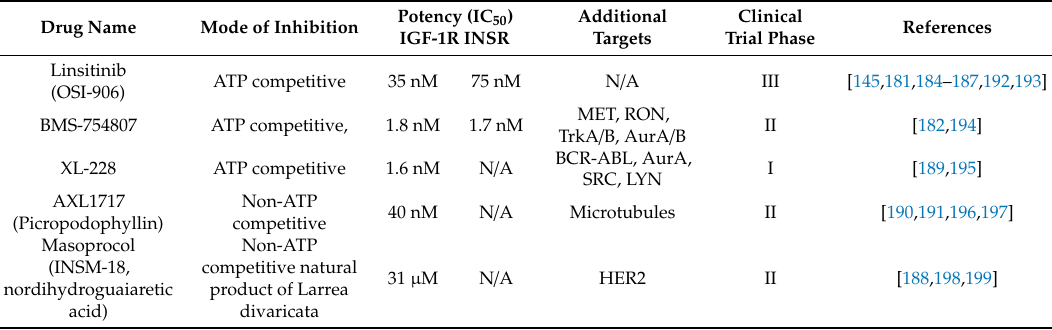
Table 2. IGF-1R Tyrosine Kinase Inhibitors (TKIs) that have undergone clinical